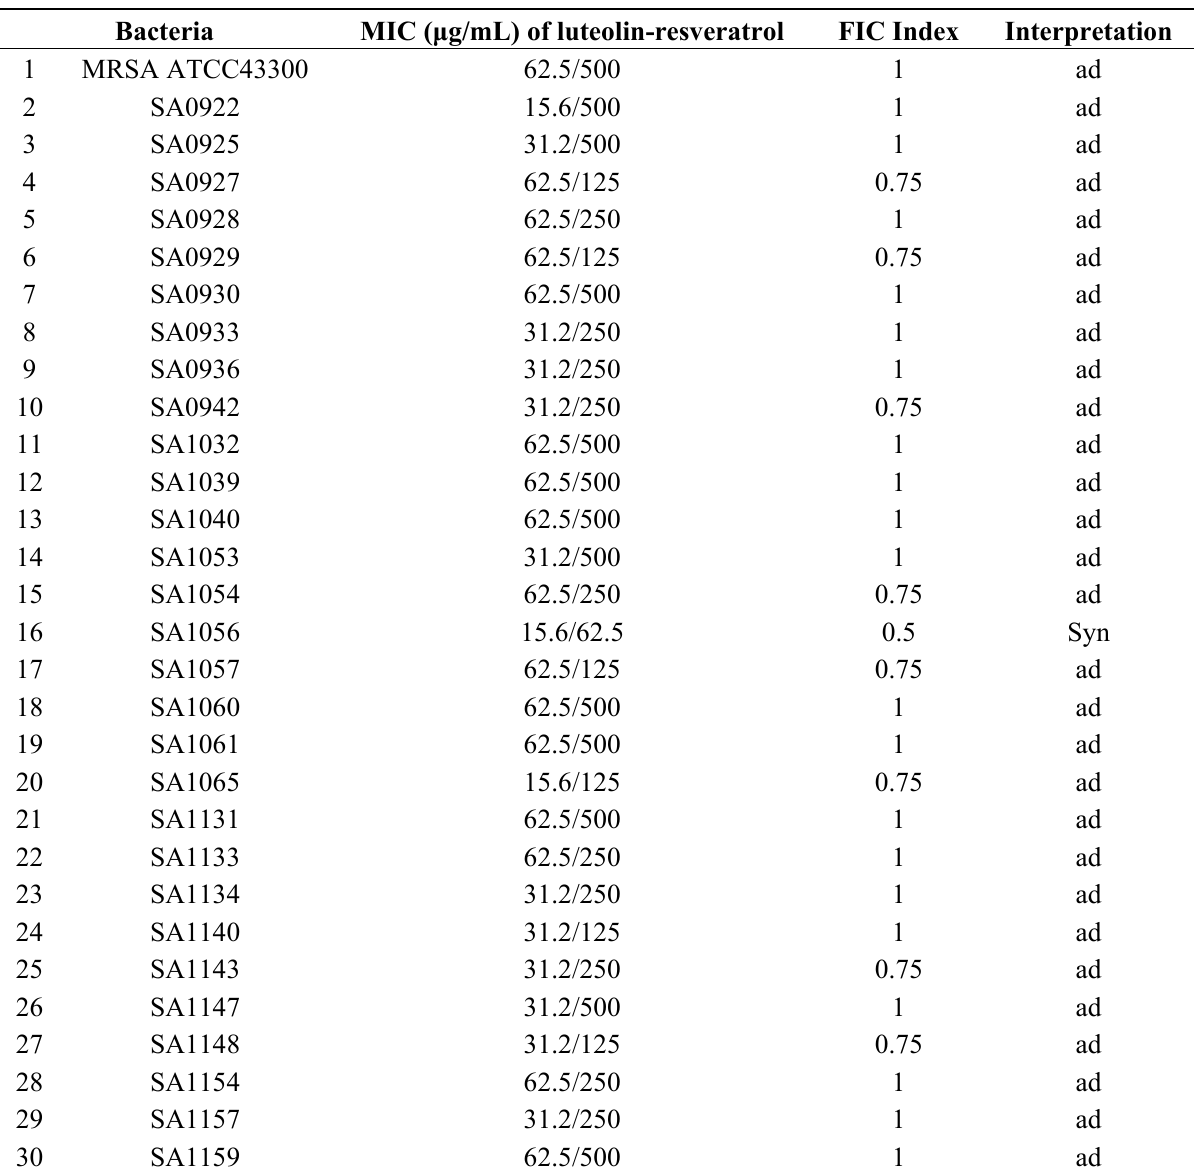
Table 3. FIC indexes of two-drug combination of luteolin-resveratrol against 30 MRSA strains.